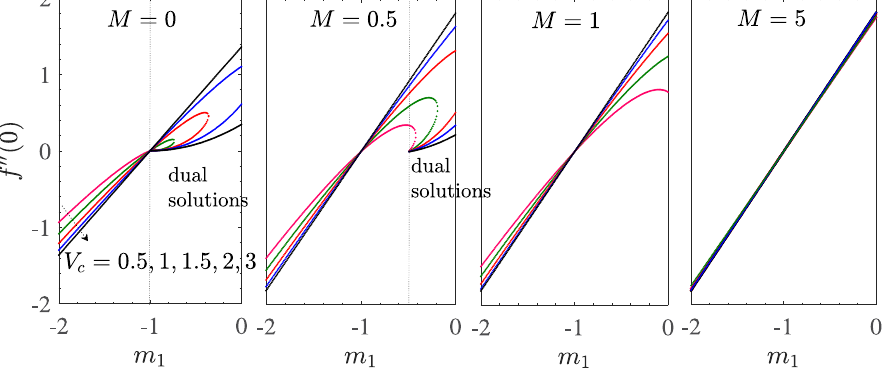
Fig 3. f 00 (0) vs m 1 for γ ! 1 , γ 1 = 0.1 = − γ 2 , d = − (1 + m 1 ) for the shrinking sheet case with mass